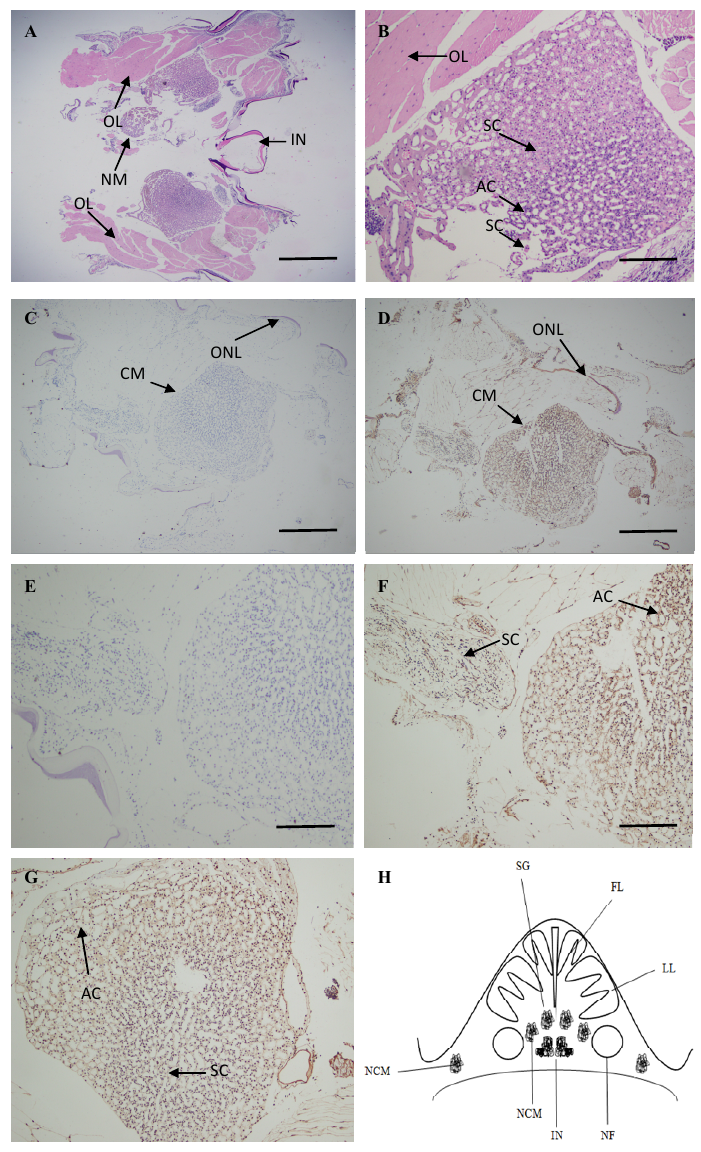
Figure 5. In situ hybridization of M. nipponense ATG4B transcripts in the brain tissue. ( A ) Photograph of M. nipponense overall brain including the nervous mass (NM), optic lobe (OL) and intermediate neurons (IN). ( B ) Nervous mass of M. nipponense showing secretory cells (SCs) and astrocyte cells (ACs). ( C ) and ( E ) Sense probes were used as negative controls. ( D ) ATG4B expression in the brain tissue of prawns in the cell mass (CM) and optic nerve lamella (ONL). ( F ) and ( G ) ATG4B was mainly expressed in the secretory cells and astrocytes cells of prawns in response to normoxia and hypoxia for 24 h, secretory cells and astrocytes cells have been distinguished with different shape, such as round and oval. ( H ) A schematic of the organization of the prawn brain. SG: spinal ganglion cells, NCM: neural cells mass, IN: intermediate neurons, NF: nerve fibers, FL: frontal lobe, LL: lateral lobes. Scale bar: 20 μm ( A , C , D ), 50 μm ( B , E , F , G ).